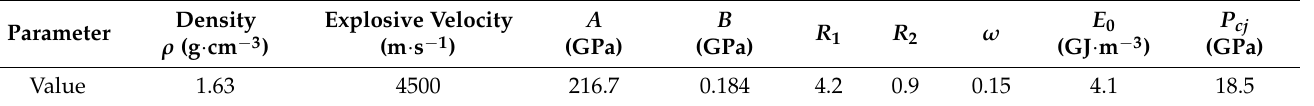
Table 4. Explosives state equation parameters.